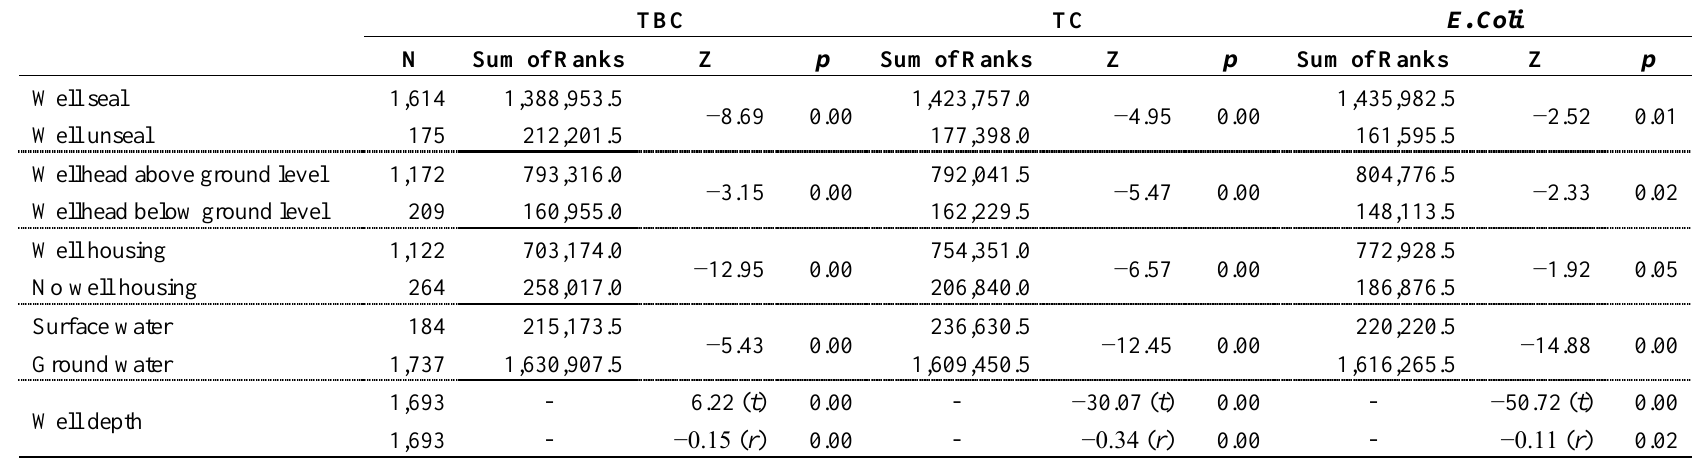
Table 2. Mann-Whitney U test, paired-samples t test and Spearman-correlation analysis of water source types and well